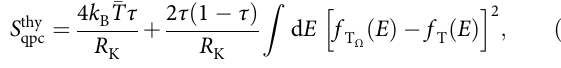
= J lim (cid:4) 2 : 5) is given by τ ð T Ω Þ times the Q Q